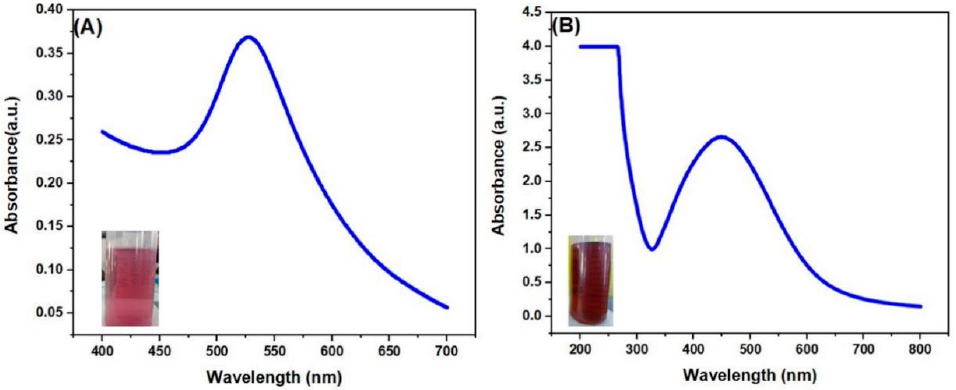
Figure 1. UV-vis spectrum of synthesized ( A ) AuNPs and ( B ) AgNPs.